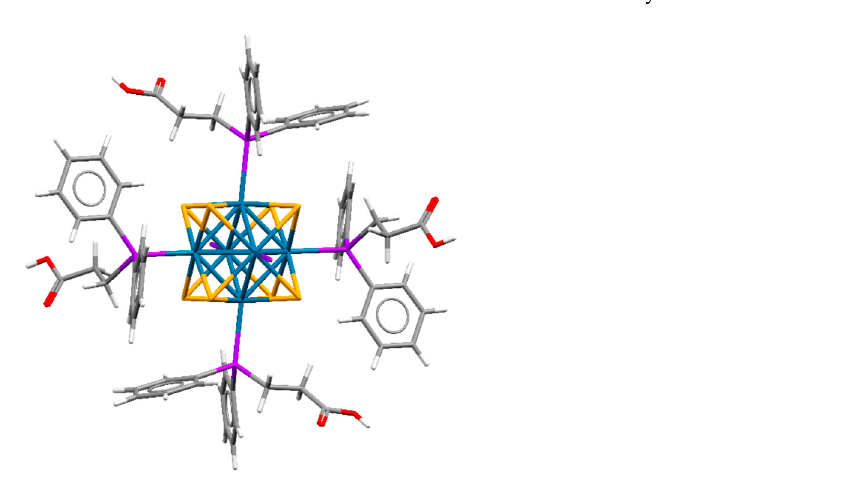
Figure 1. Structure of neutral cluster complexes [{W 6 Q 8 }(PPh 2 C 2 H 4 COOH) 6 ]. Two phosphine ligands are omitted for clarity. W—blue, Q—orange, P—purple, C—grey, H—white, O—red. Table 1. M–P bond length analysis (M = Mo, W, and Re).